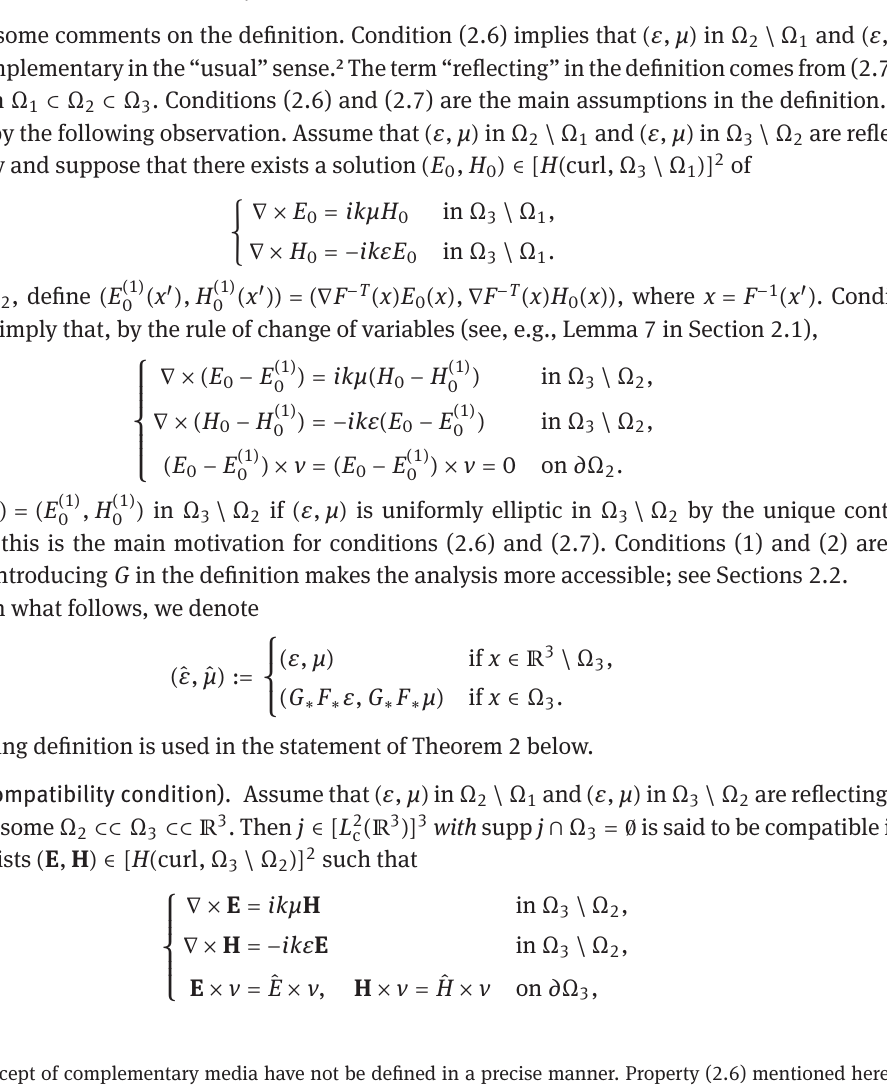
\ Ω 3 2 for some diffeomorphism F from Ω 2